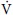
Relationship between CO2 production and emphysematous changes.The CO2 production at the peak exercise (peak V˙
co
2) was inversely correlated with the total LAA scores (p<0.0001, r = -0.433).